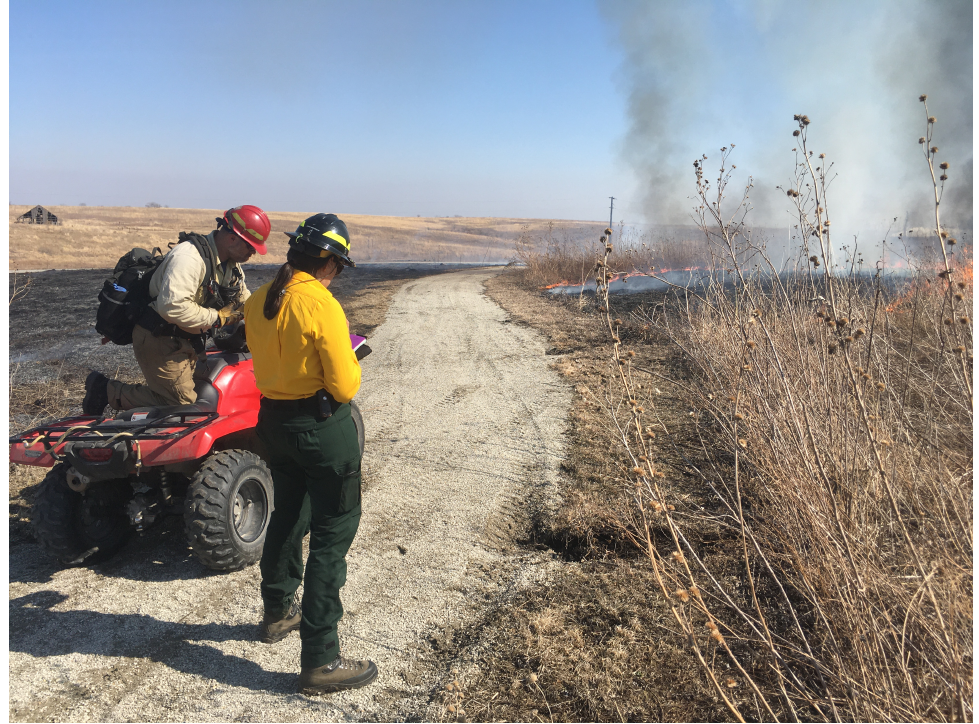
Figure 12. A Type 5 Incident Commander (ICT5) trainee who participated in the workshop practices an incident size up on a spot fire that the workshop cadre allowed to slop over across a narrow walking path between two patches of tallgrass fuels used in the first training